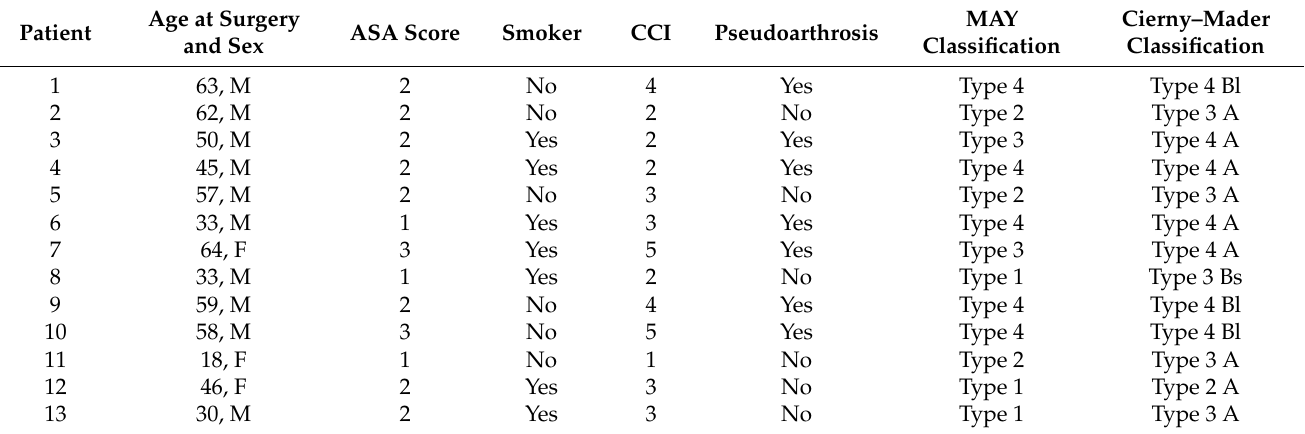
Table 1. Patients’ characteristics at baseline. ASA score: American Society of Anesthesiologists classification; CCI: Charlson Comorbidity Index.